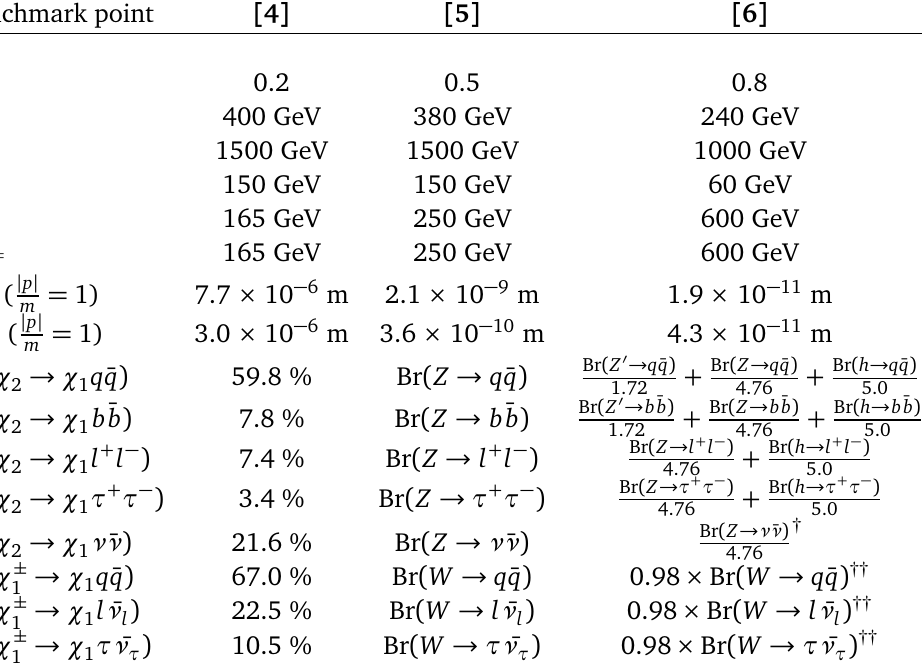
Table 2: Summary of non-thermal benchmark points for scan of LHC searches. For point [ 6 ] we write out the decay modes contributing to the final branching ratio for an experimental signature to demonstrate that larger mass hierarchies in the dark sector means these can no longer be described by (phase-space suppressed) W / Z branching ratios but rather can include cascade decays into Z (cid:48) and h with modified kinematics, introducing new signatures.